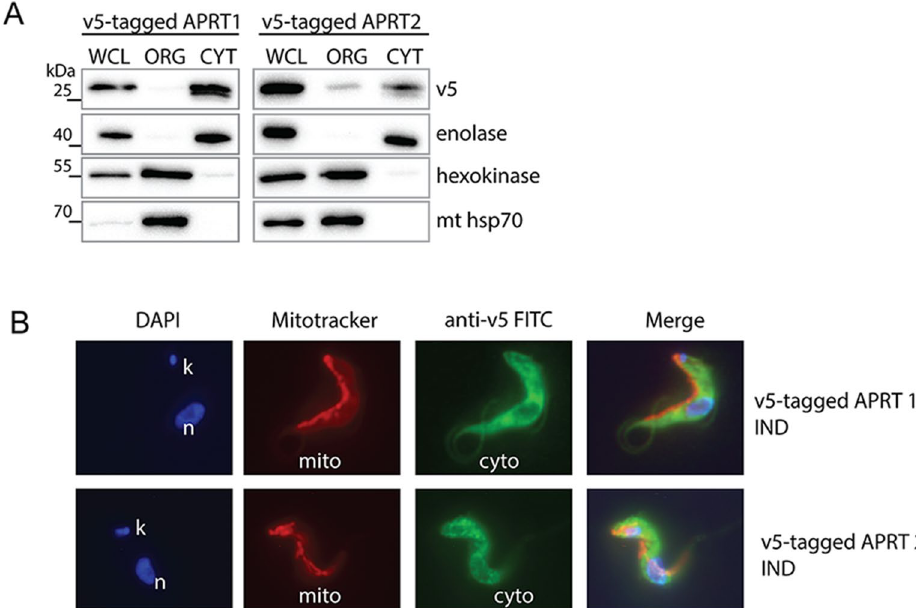
Figure 2. Subcellular localization of APRT1 and 2 in the BSF T. brucei cells. ( A ) Western blot analysis of the BSF cells overexpressing V5-tagged APRT1 and 2 which were treated with digitonin to obtain cytosolic and organellar fractions. The purified fractions were analysed with the following antibodies: anti-V5, anti- enolase (cytosol), anti-hexokinase (organellar fraction, glycosomes), and anti-mt hsp70 (organellar fraction, mitochondria). The protein marker is indicated on the left. ( B ) Immunofluorescence microscopy of the tetracycline induced (IND) V5-tagged APRT1 and 2. The tagged proteins were visualized using a monoclonal V5-antibody and an anti-mouse secondary antibody conjugated with fluorescein isothiocyanate (FITC). The MitoTracker Red was used to visualize mitochondria, while the DAPI was used to stain the DNA content [nucleus (n) and kinetoplast (k)] of the cell. WCL whole cell lysate, ORG organellar fraction, CYT cytosolic